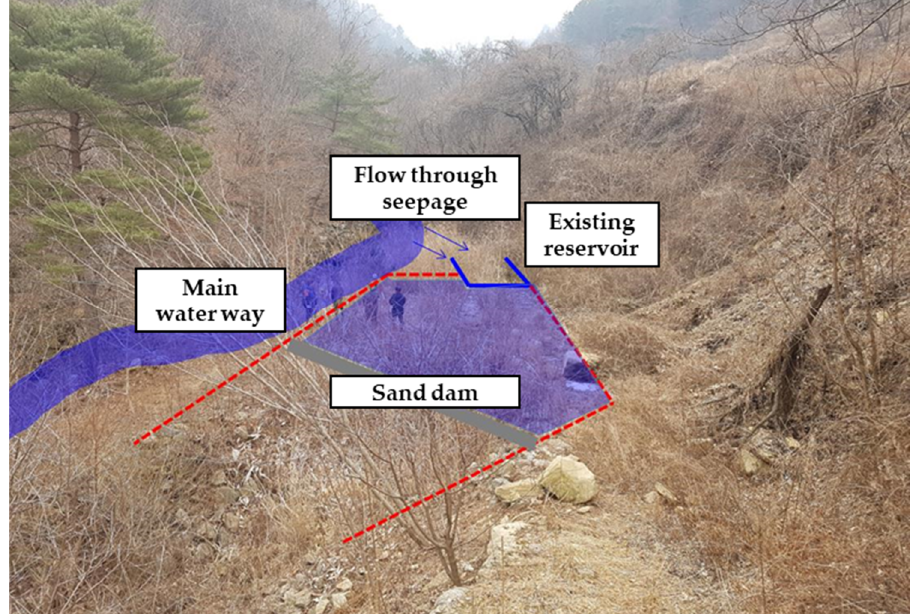
Figure 2. Photos showing the sand dam location.